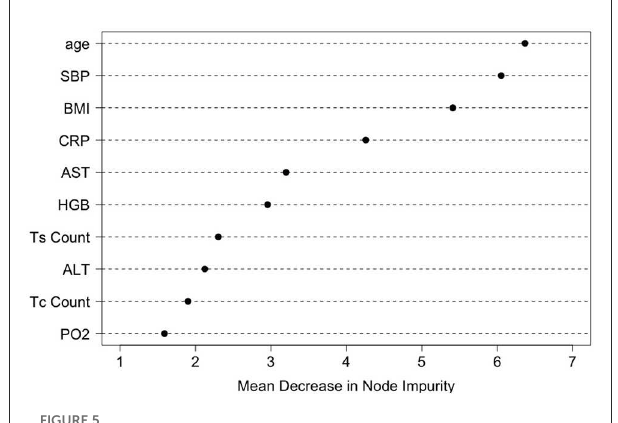
FIGURE5 Variable importance ranking by the random forests in terms of the total decrease in node impurity (i.e., residual sum of squares) from splitting on the variable, averaged over all trees.